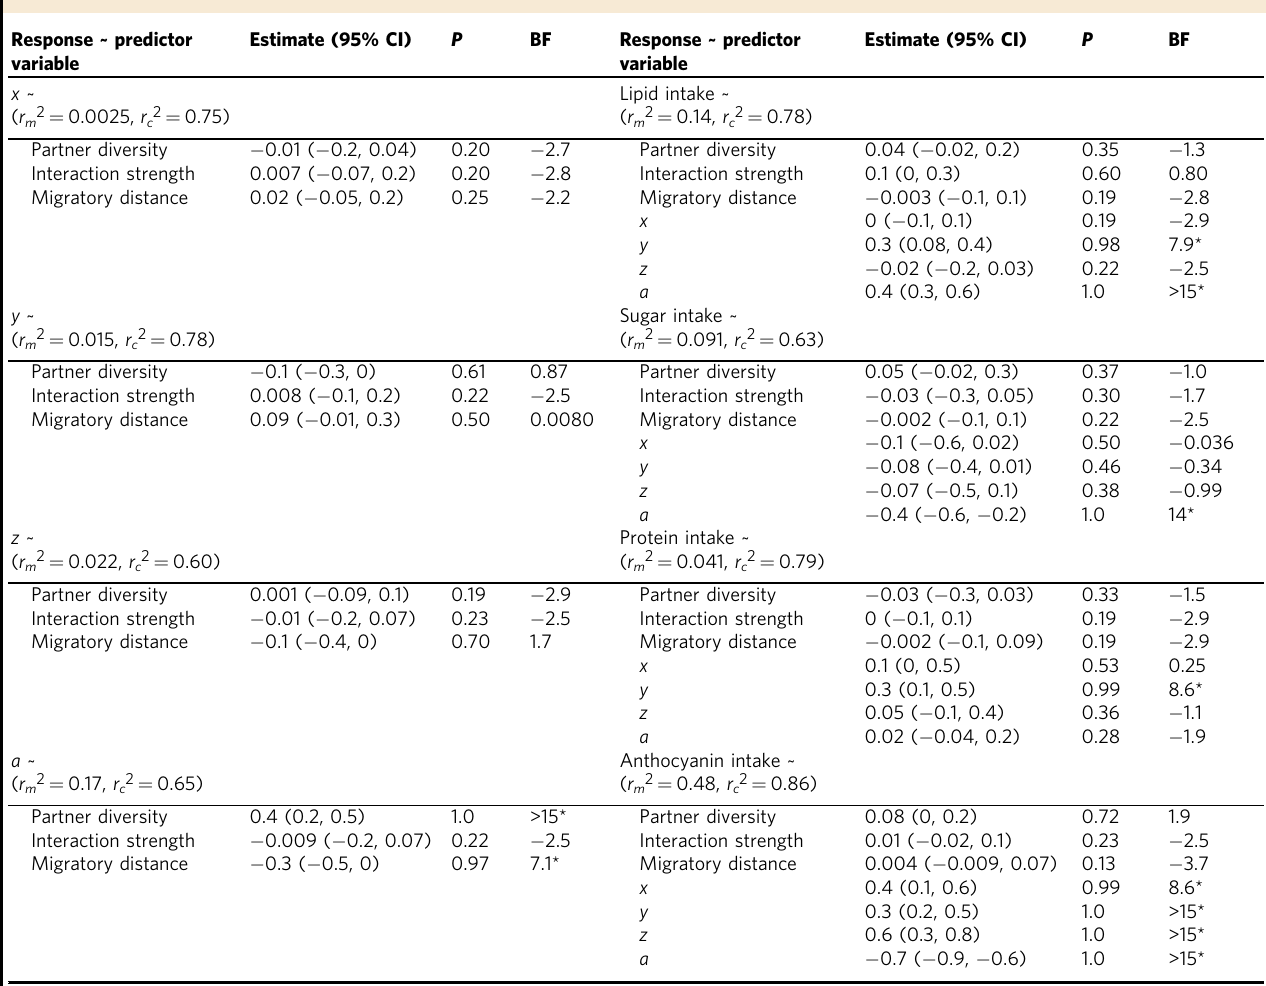
Table 2 Summary of Bayesian hierarchical structural equation model Response ~ predictor